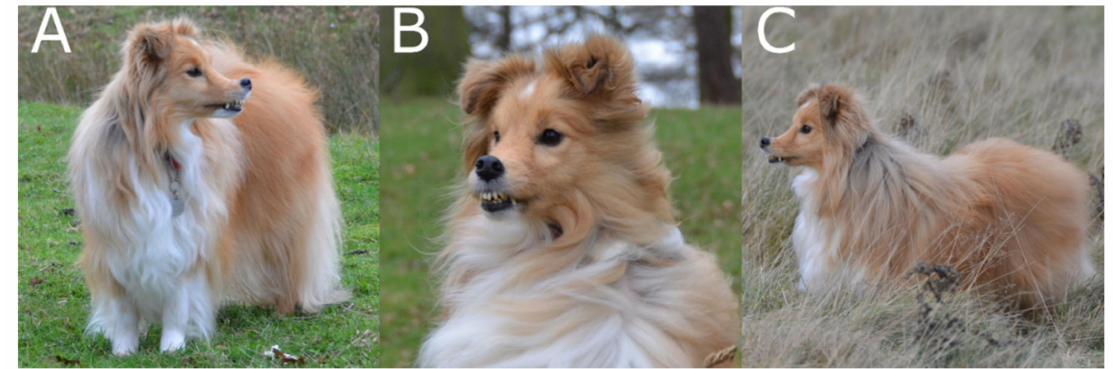
Figure 1. Photographs of PRA-affected proband SS1 in the initial litter show the uncharacteristic ‘wavy’ coat, upturned nose and dental defects ( A – C